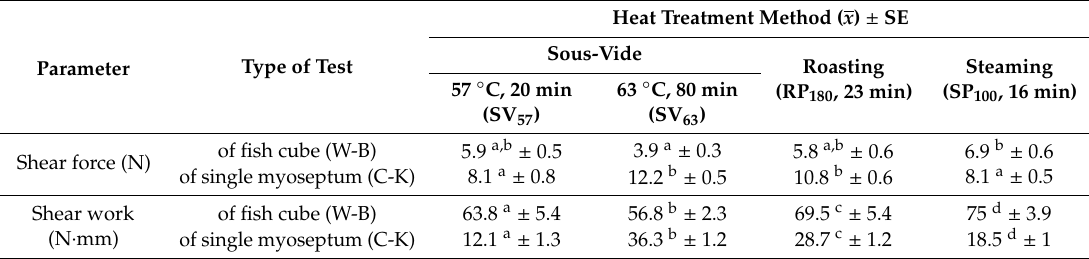
Table 6. Texture of salmon processed with various heat treatment